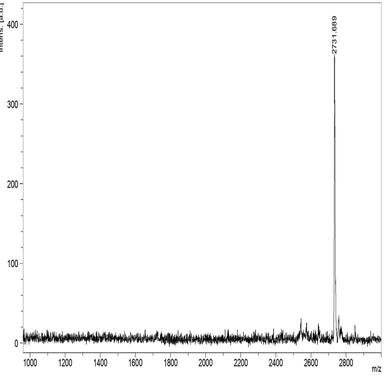
The MALDI-TOF mass spectrum of LuPc2.